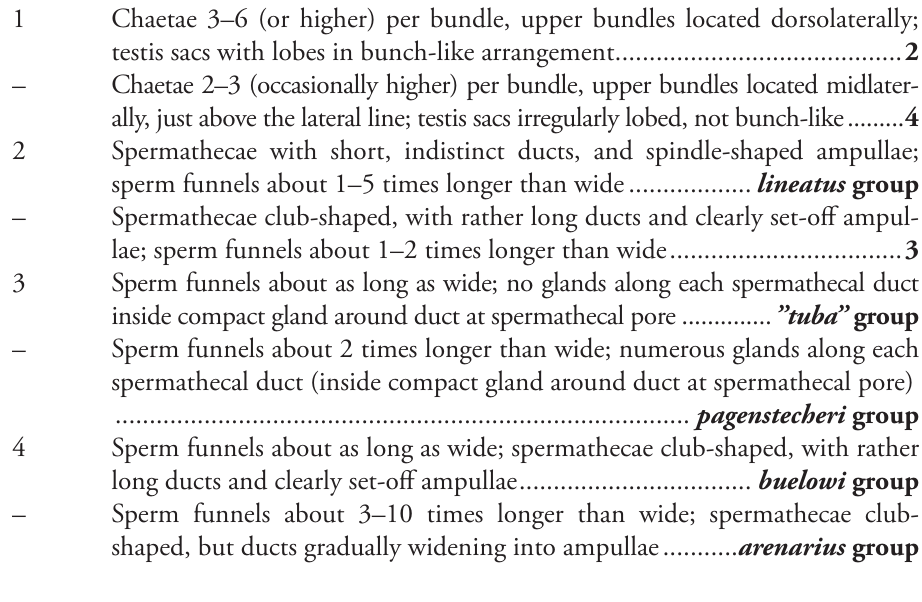
Preliminary key to species groups (based on species included in study